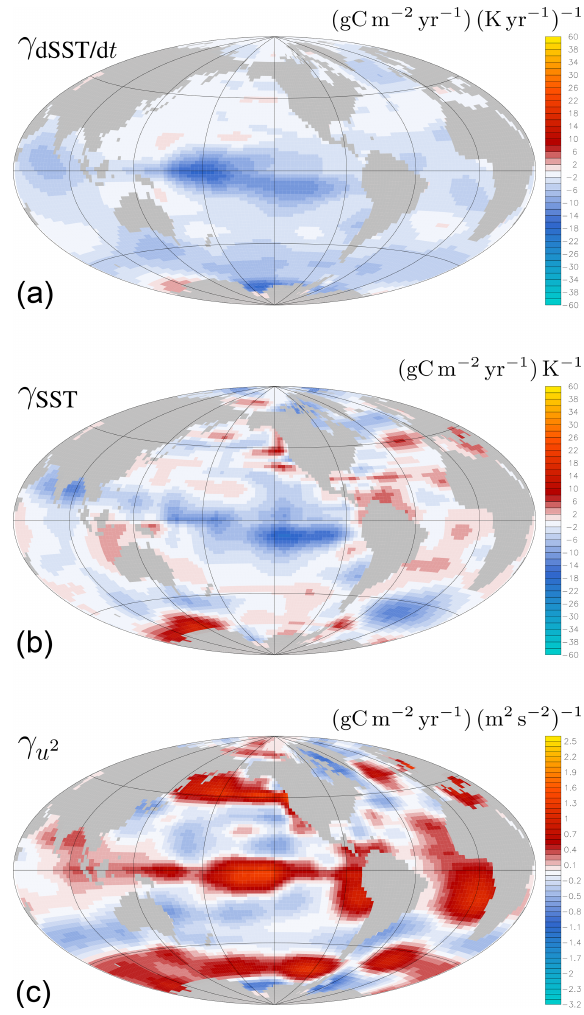
Figure 4. Estimated sensitivities of the ocean-internal DIC flux f int against interannual variations in the temporal changes in sea sur- face temperature (a) , in the sea surface temperature itself (b) , and in squared wind speed (c) . Positive (negative) sensitivities mean that increases in the respective explanatory variable are associated with a stronger source (stronger sink) of DIC in the mixed